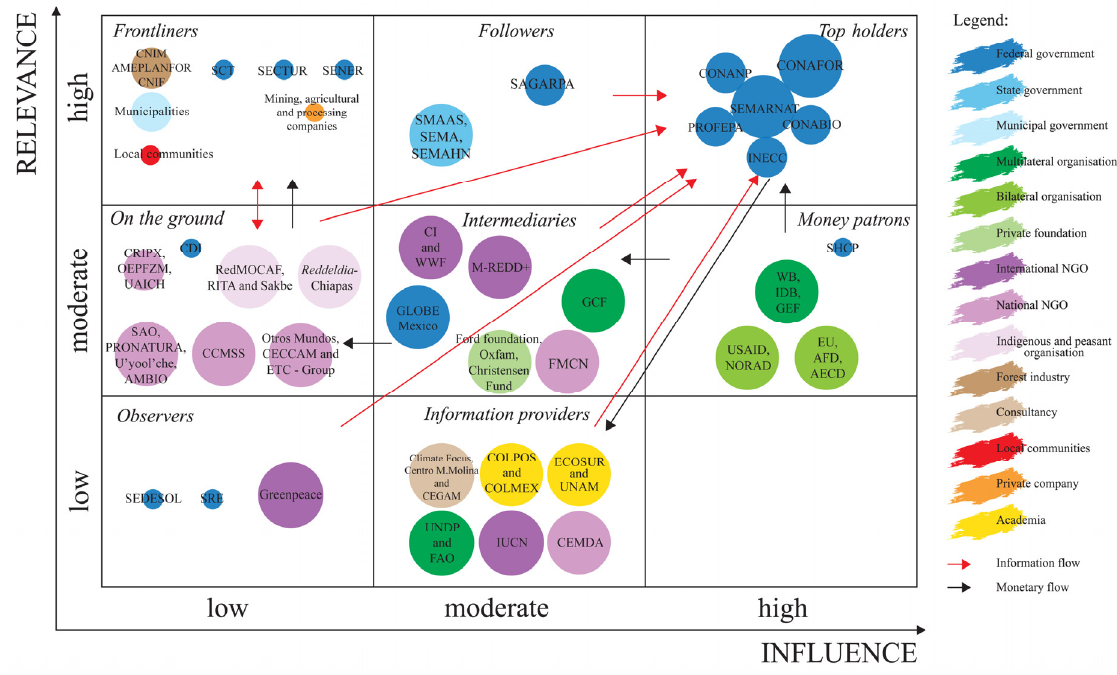
Figure 2. REDD+ stakeholder’s groups according to their relevance and influence. Colour corresponds to actor typology (figure right column legend), and size of the circle to the actor’s level of interest in REDD+ implementation. Source: own elaboration. SEMARNAT, Ministry of Environment and Natural Resources in Spanish; CONANP, National Commission of Protected Areas; PROFEPA, Office